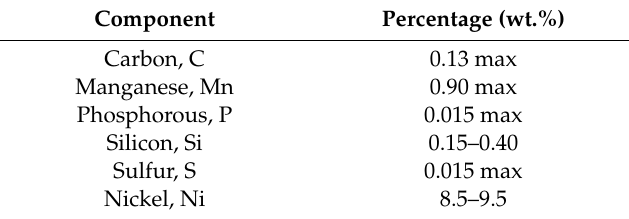
Table 2. The chemical composition of ASTM A553 Type 1 (9% nickel steel).